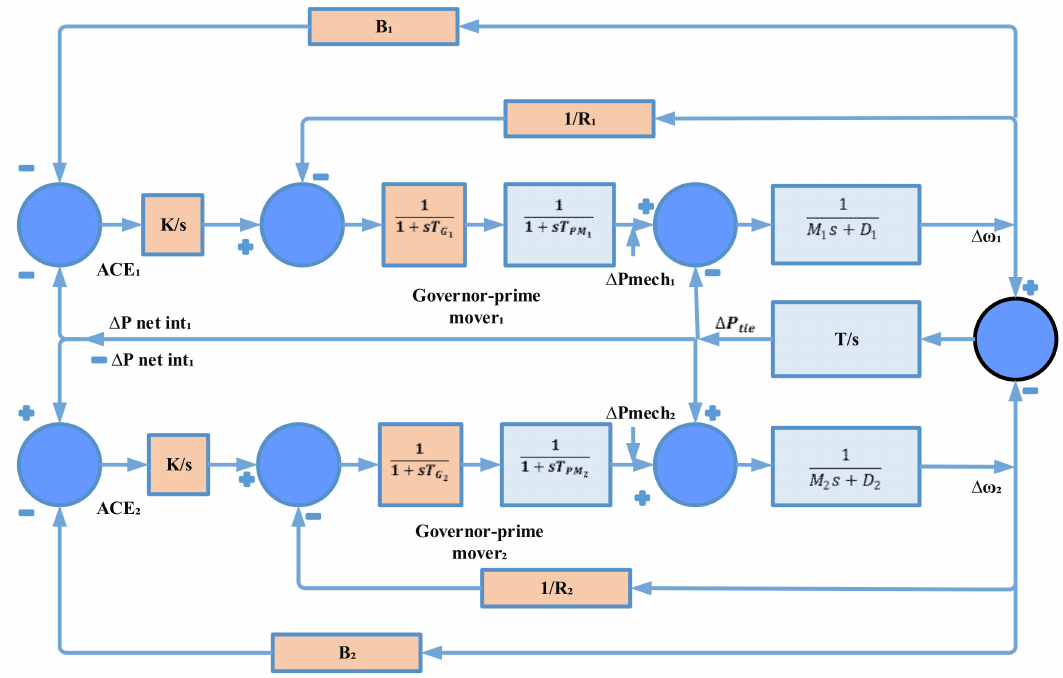
Figure 1. Conventional load frequency control model for two